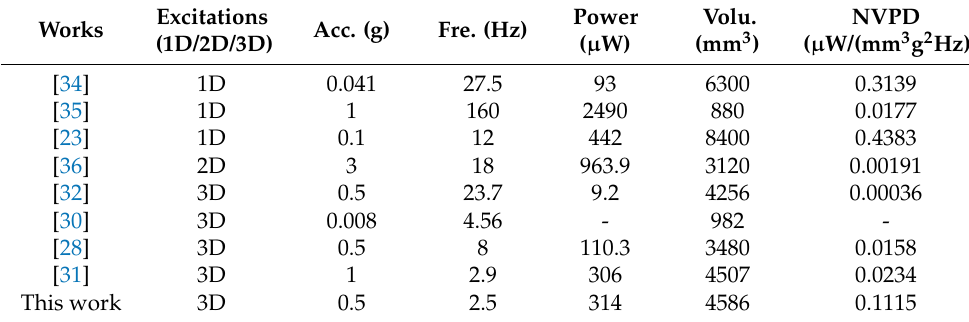
Table 3. Comparison of the proposed and some existing